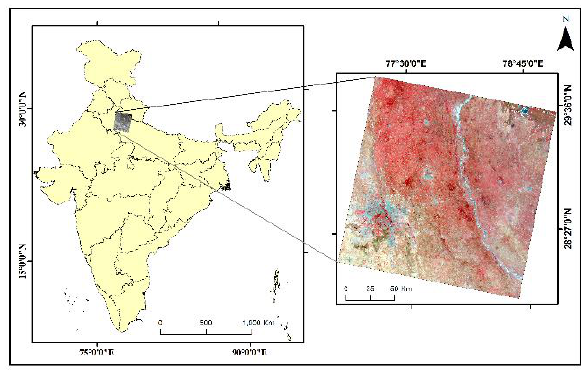
Figure 1. Location Map of Study Area According to Koppen climatic classification, Delhi shows and overlapping kind of climate between monsoons influenced humid subtropical and semi-arid. Here, the variation between summer and winter in precipitation and temperature is quite high and significant. Temperature ranges between 45 0 in summer to near freezing in